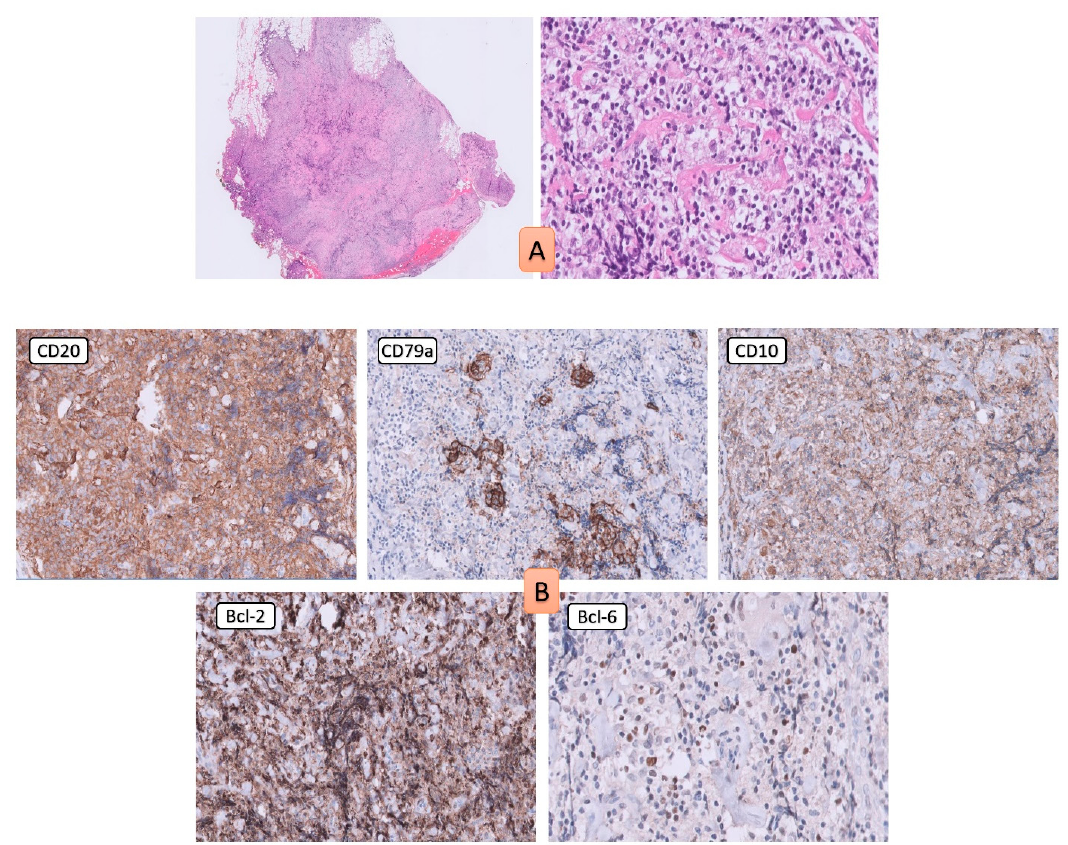
Figure 3. Resected ileum tissue showed centrocyte and centroblast ( A ). Cells were positive on CD20, CD79a, CD10, bcl-2, bcl-6 ( B